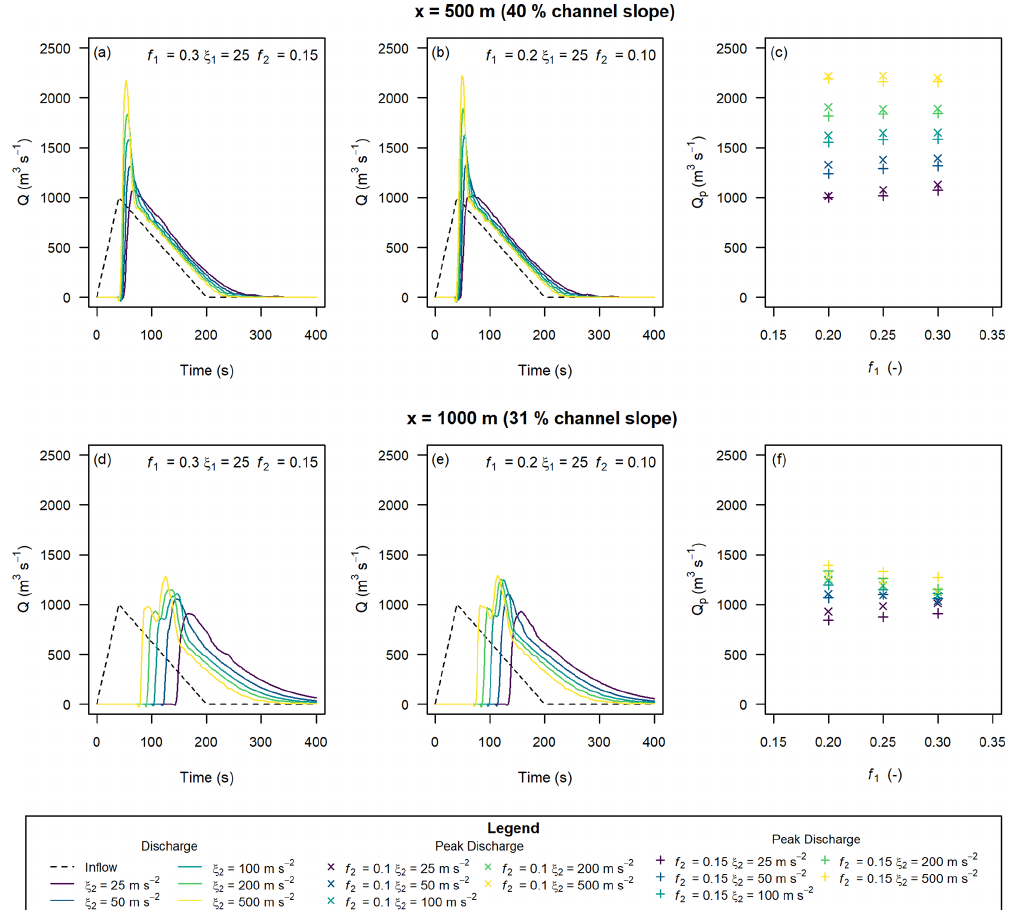
Figure 7. Effects of having two sets of Voellmy parameters ( f 1 and ξ 1 on the rising limb and f 2 and ξ 2 on the falling limb of the inflow hydrograph) on the downstream